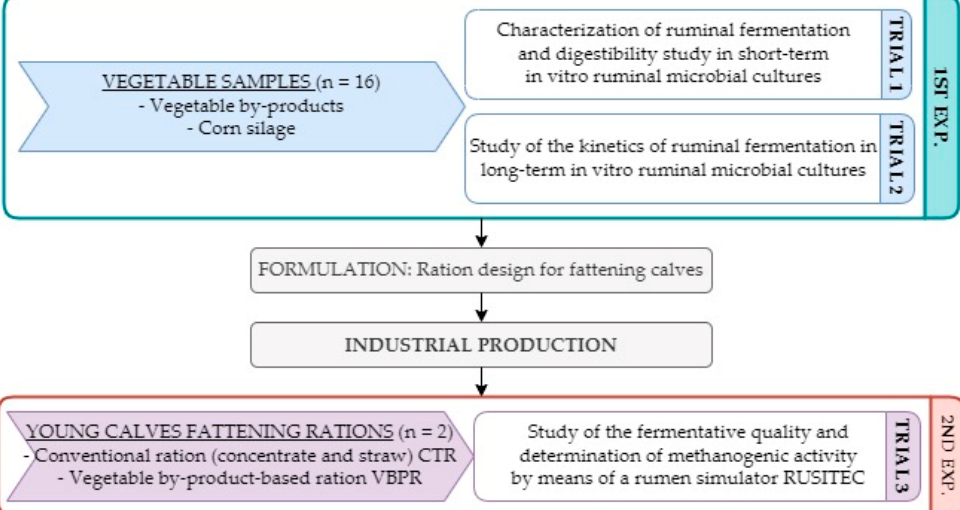
Figure 1. Visual scheme of the experiments and trials performed.